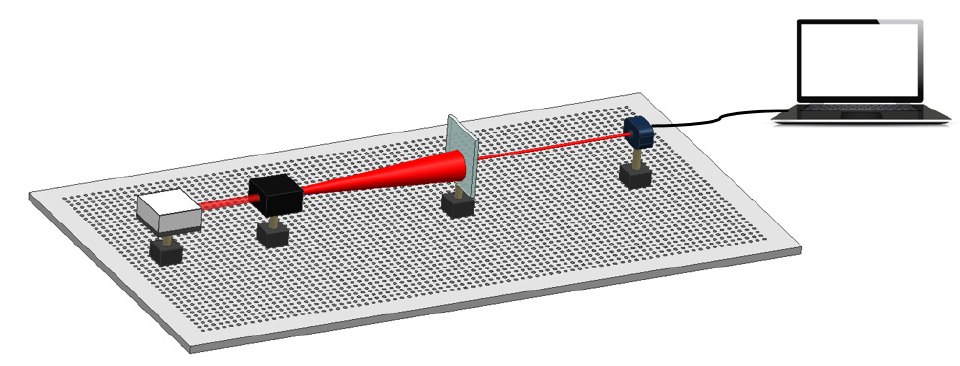
Figure 12. Sketch map of the experimental setup. From left to right are laser source, beam expander, the CSZPG , CCD and computer.